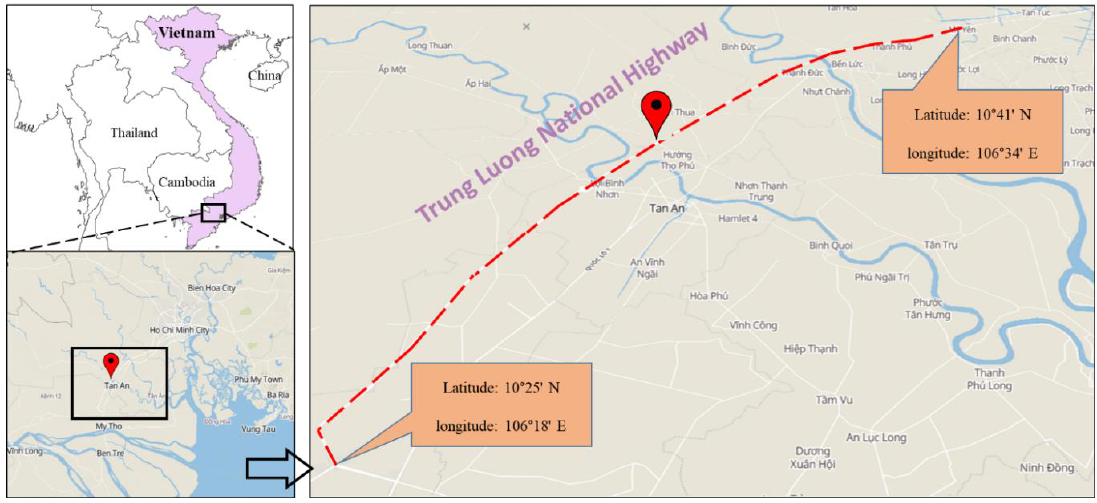
Figure 3. Location of the studied track.